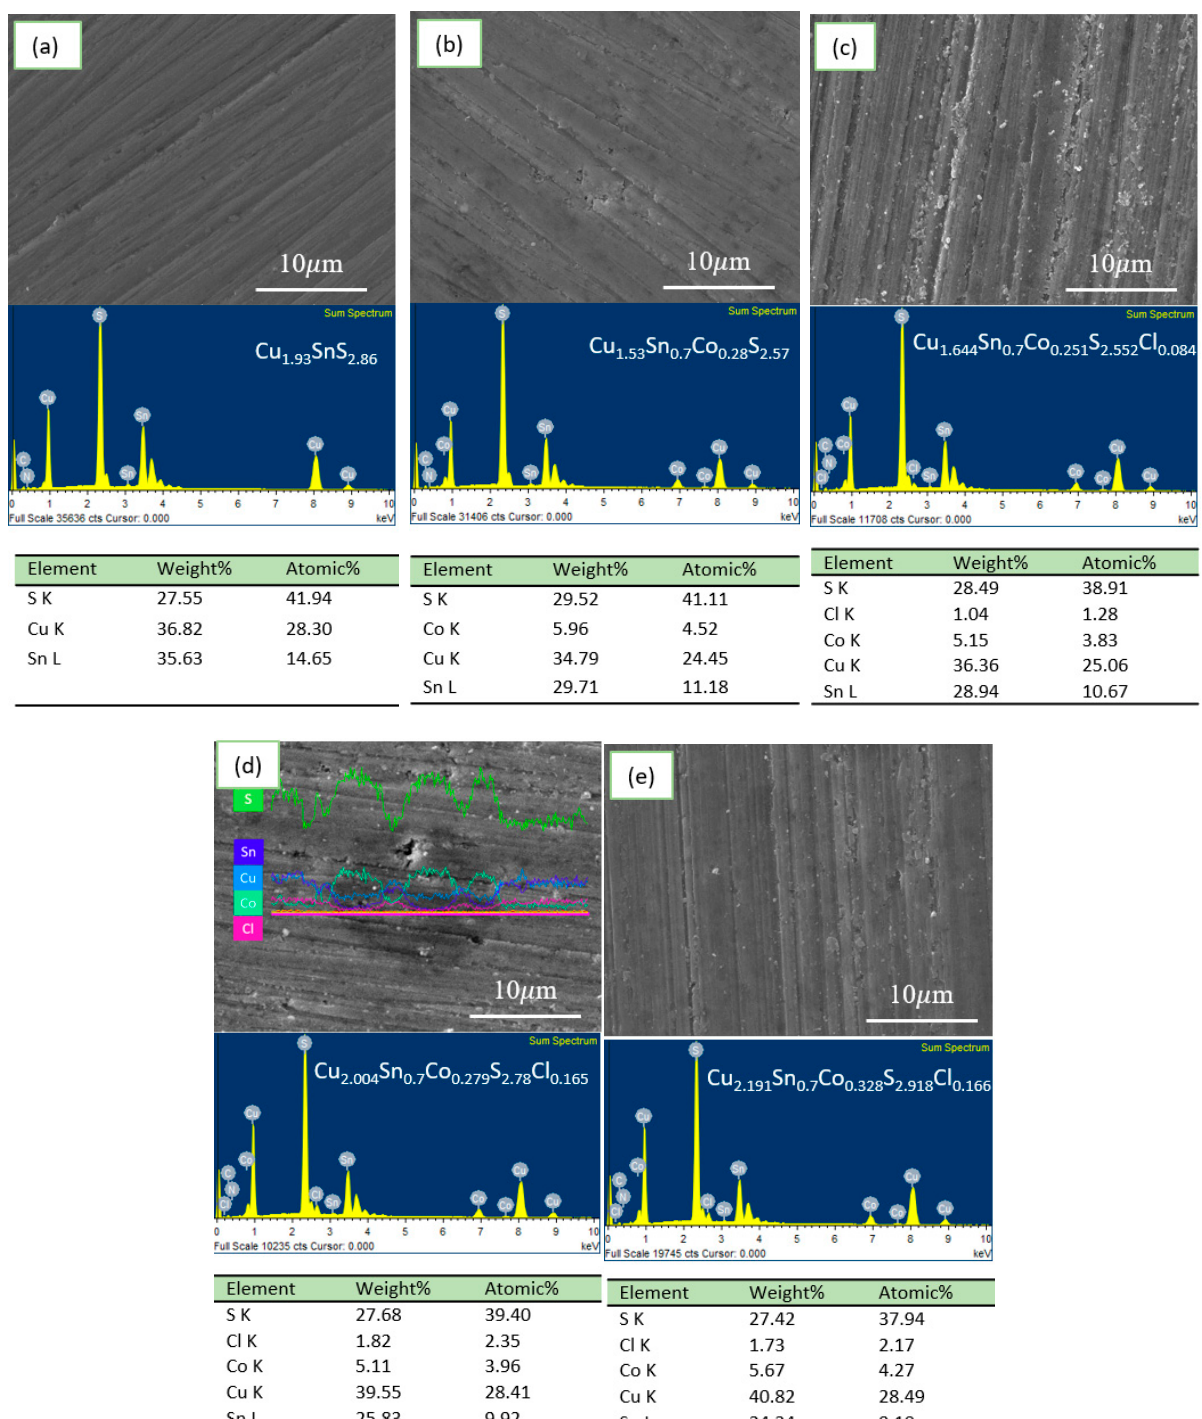
Figure 3. ( a – e ) Scanning electron microscopy (SEM) and energy-dispersive X-ray spectra (EDX) analysis for the polished surface of the sample. ( d ) The linear EDX analysis for sample CSCS-